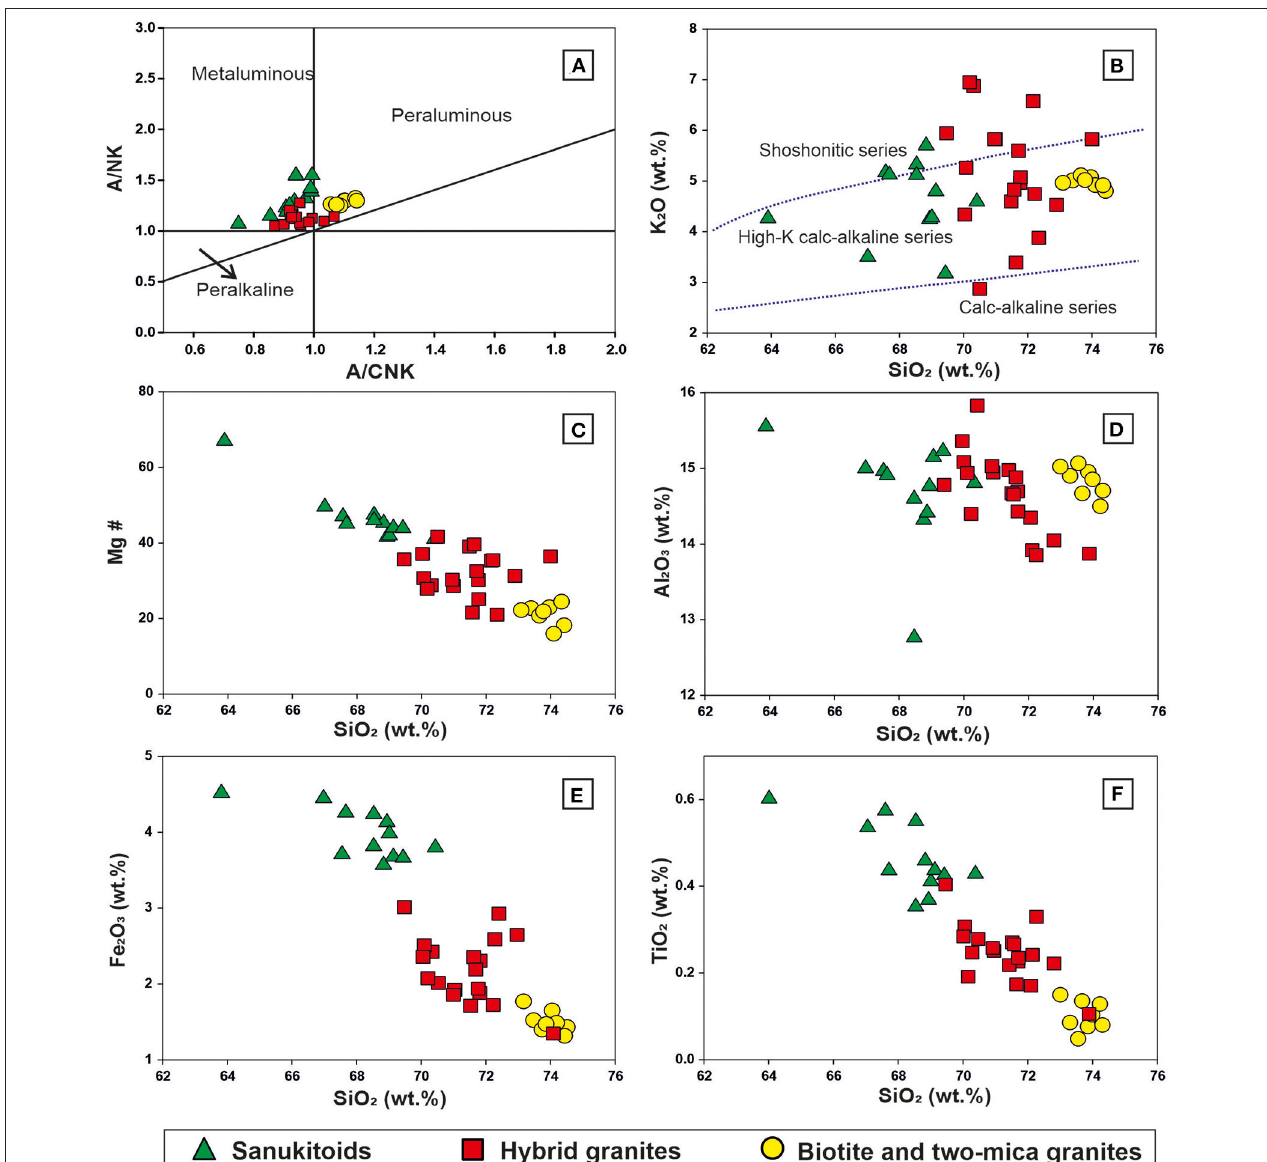
FIGURE 5 | (A) Alumina Saturation Index diagram (Shand, 1943), wherein the sanukitoids are confined to metaluminous field, biotite and two-mica granites are into peraluminous field. The hybrid granites are distributed among both fields. (B) SiO 2 vs. K 2 O diagram (after Le Maitre, 1989) to show the variations in the melt affinity of different granite types of Kanker pluton. (C) SiO 2 vs. Mg# plot, wherein the sanukitoids with high Mg# suggest the mantle involvement (Rapp et al., 1999). (D–F) Harker variation diagrams depicting the major elemental compositional variations among the granite types of Kanker pluton. Note the compositional variability of hybrid granites and their distribution between the compositional range of sanukitoids and biotite and two-mica granites.